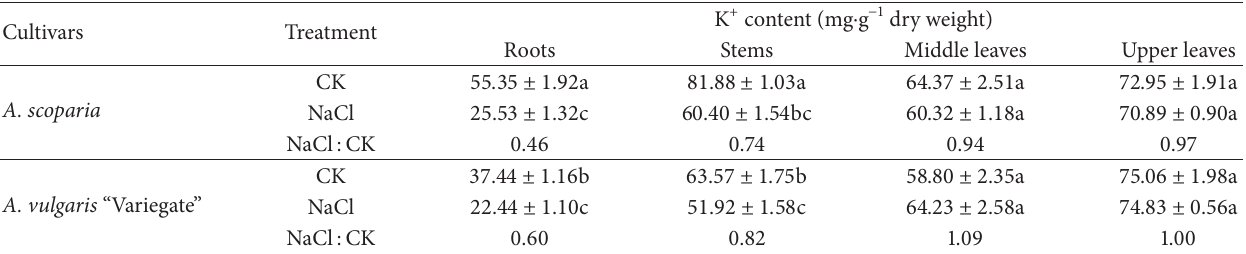
Table 2: Effects of NaCl stress on K + content in different organs of A. scoparia and A. vulgaris “Variegate.”